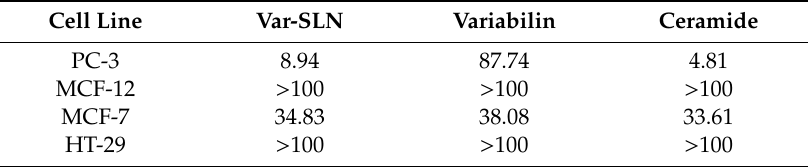
Figure 7. Effect of variabilin and Var-SLNs against cancer and non-cancer cell lines. The cells: PC-3 cells ( A ), MCF-12 ( B ), MCF-7 ( C ), and HT-29 ( D ) were exposed to increasing concentrations of variabilin and Var-SLNs, cell viability was assessed by WST-1 assay. * Statistical significance ( p < 0.05). Table 2. IC 50 ( μ M) of Var-SLN, Variabilin and Ceramide. Cell line Var-SLN